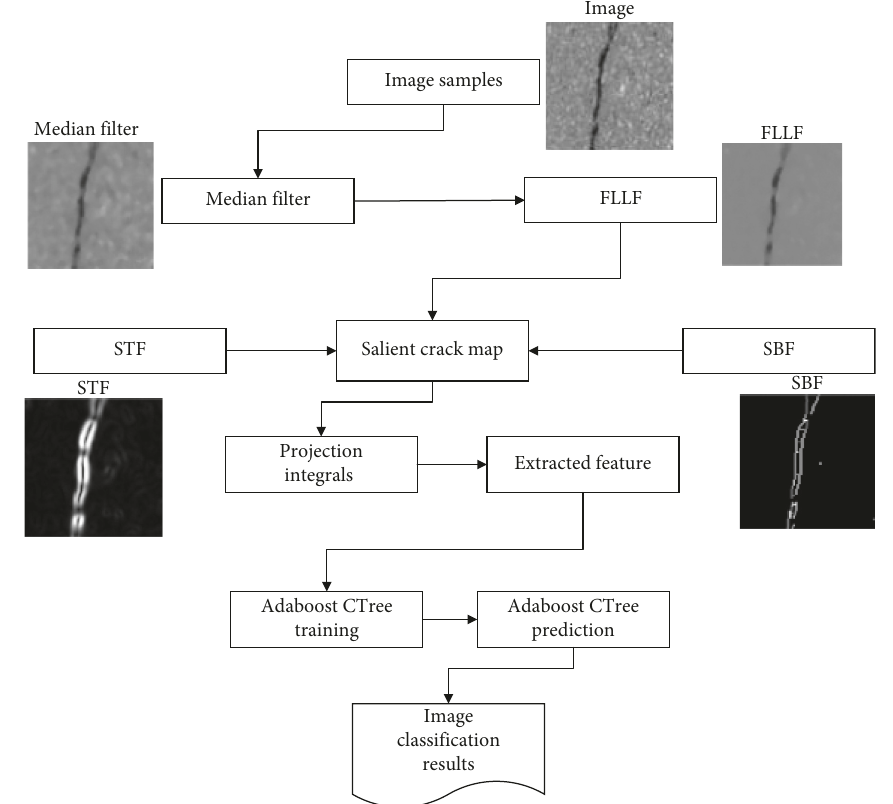
Figure 8: The proposed pavement crack classification